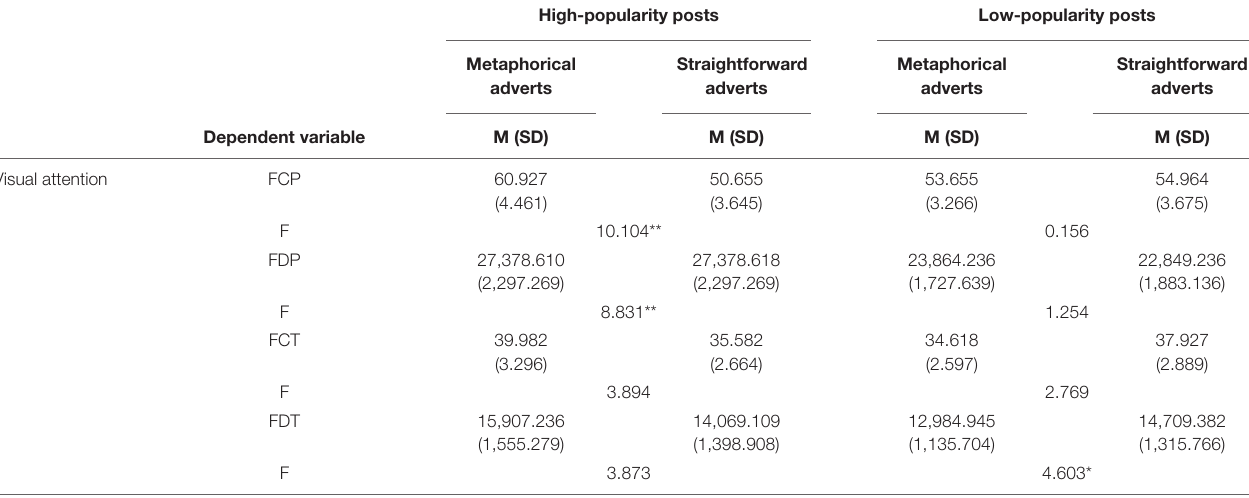
TABLE 3 | Pairwise